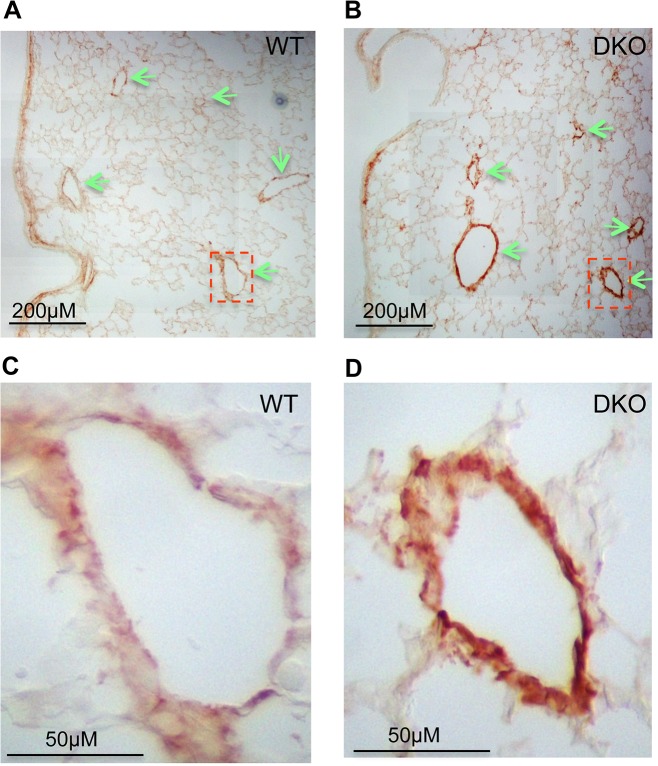
Upregulation of COL1A1 in distal vasculature of miR-29 DKO lungs.
(A&B) Increased COL1A1 IHC signal is prominently associated with vessel walls, where endogenous miR-29 expression is highly expressed. (C&D) are enlarged images of highlighted areas of A&B by dashed line. All images are representative of four pairs of littermate-matched WT/DKO mice.